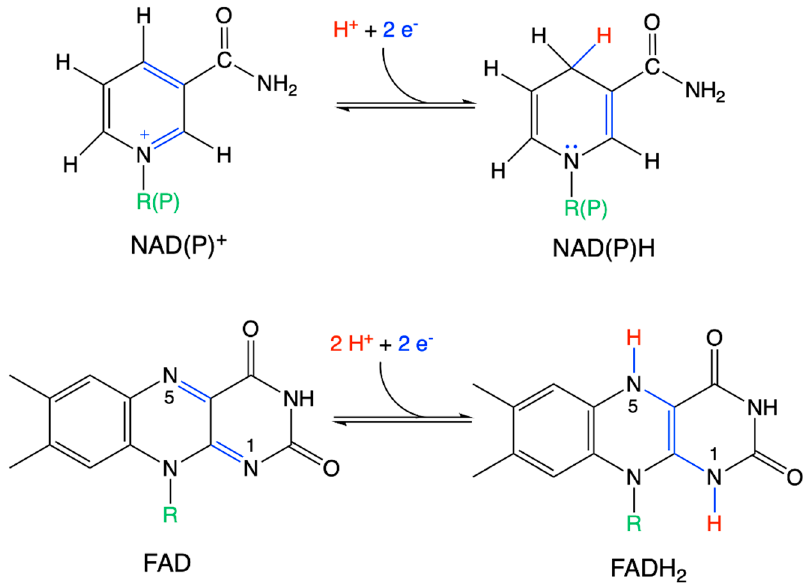
Figure 5. Structures of the oxidized and reduced forms of NAD(P) + /NAD(P)H and FAD/FADH 2 . Electron rearrangements are shown in blue and hydrogenations are shown in red.